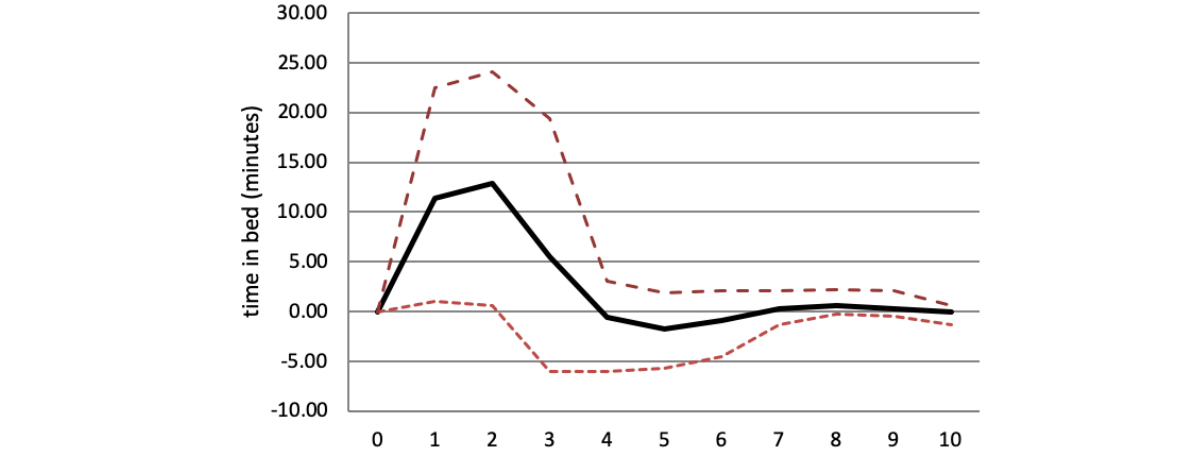
Figure 2. Impulse response function for patient 2. Impulse represents depression severity, response is time in bed, time horizon = 10 days; the dashed line indicates the 95%